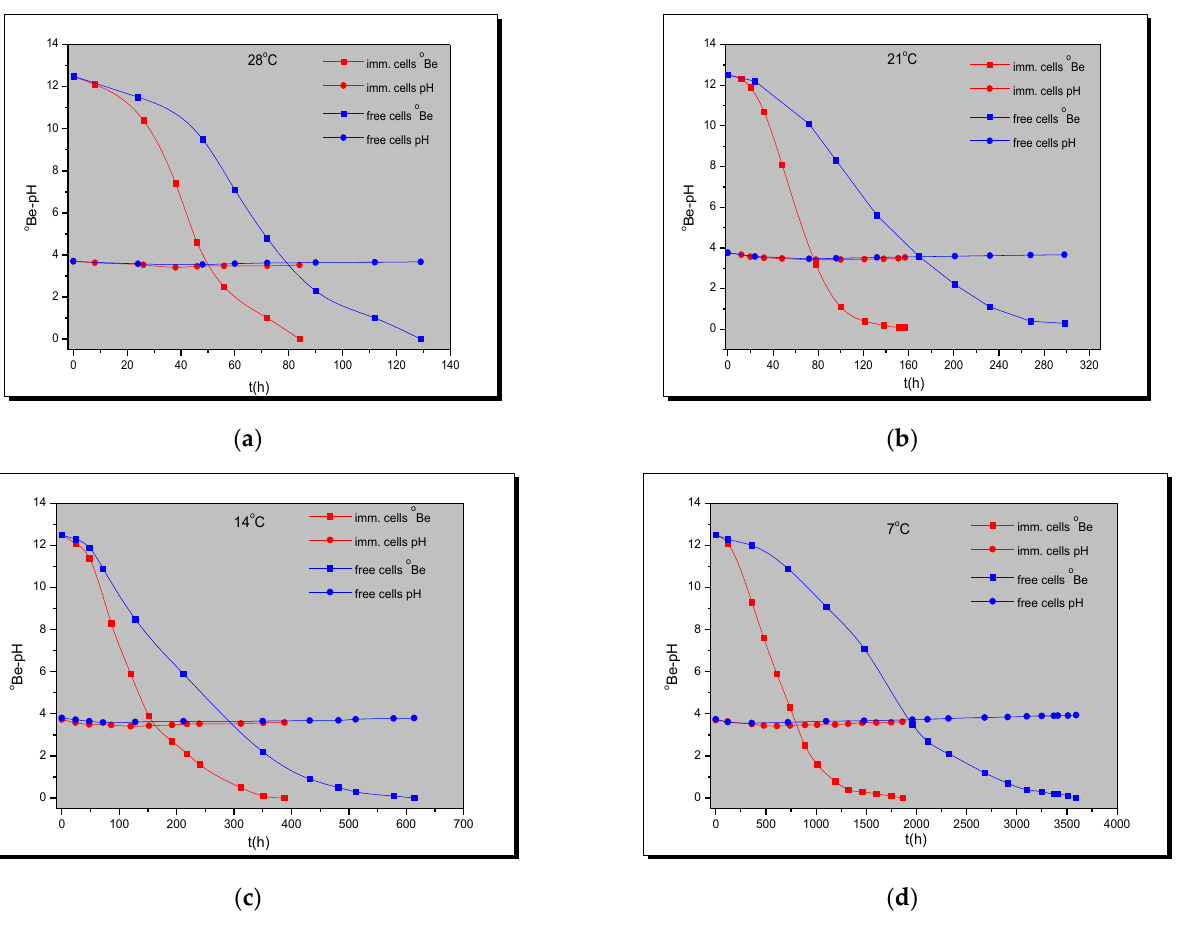
Figure 1. Fermentation kinetics of must (12.5 °Be) using immobilized and free cells at ( a ) 28 °C; ( b ) 21 °C; ( c ) 14 °C; ( d ) 7 °C.